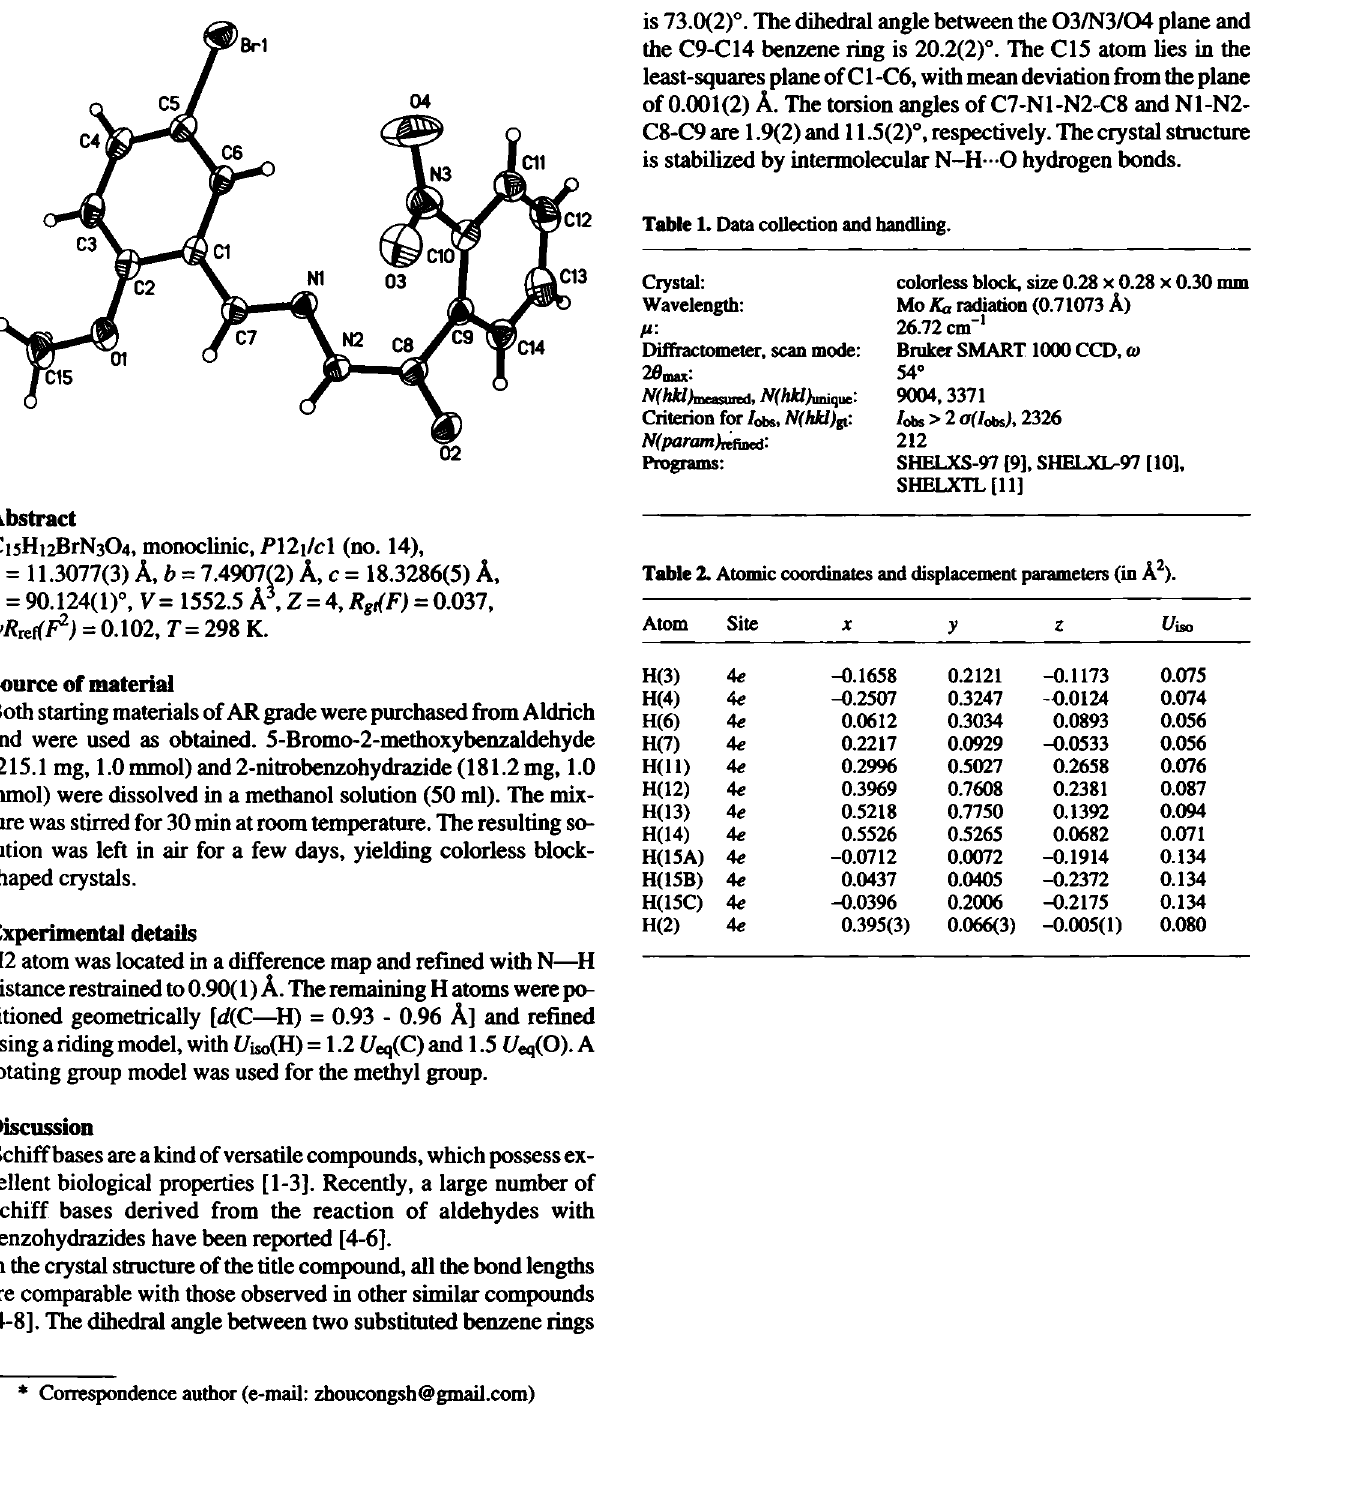
Table 1. Data collection and handling.